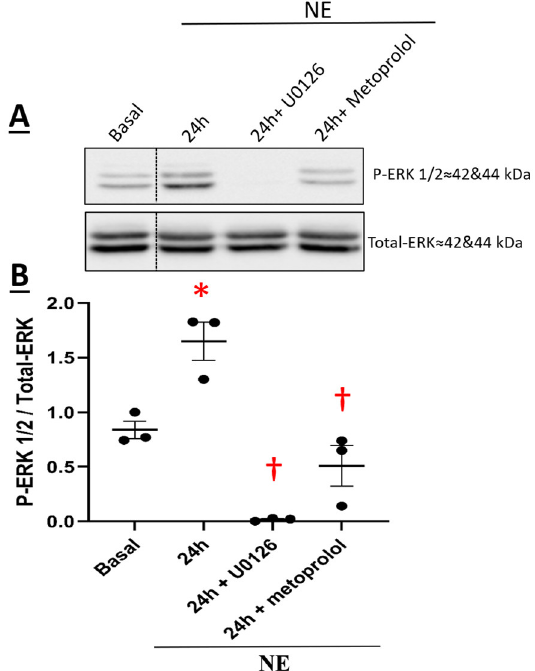
Figure 9. ( A ) Expression of P-ERK 1/2 in neonatal rat cardiomyocytes. Total proteins were extracted from neonatal rat ventricular cardiomyocytes. Cells were treated with 1 µ M Norepinephrine (NE) for 4–24 h or pre-treated with either U0126 (P-ERK1/2 inhibitor) or metoprolol tartrate ( β 1-blocker) for 1 h followed by treatment with NE for 24 h. Proteins were separated on an 8% SDS-polyacrylamide gel, transferred to a nitrocellulose membrane, and probed with anti-P-ERK, anti-total-ERK anti- bodies overnight and then incubated with HRP-conjugated goat anti-rabbit secondary antibody. Lanes were loaded with 30 µ g of proteins. NE: cardiomyocytes treated with 1 µ M norepinephrine, 24 h + U0126: Cardiomyocytes pre-treated with U0126 for 1 h followed by treatment with NE for 24 h. 24 h + β 1-blocker: Cardiomyocytes pre-treated with metoprolol tartrate ( β 1-blocker) for 1 h followed by treatment with NE for 24 h. ( B ) Graph showing the total protein expression of P-ERK normalized to total-ERK. * p < 0.01 vs. Basal; † p < 0.01 vs. NE 24 h. (3 cardio-preparations). Statistical